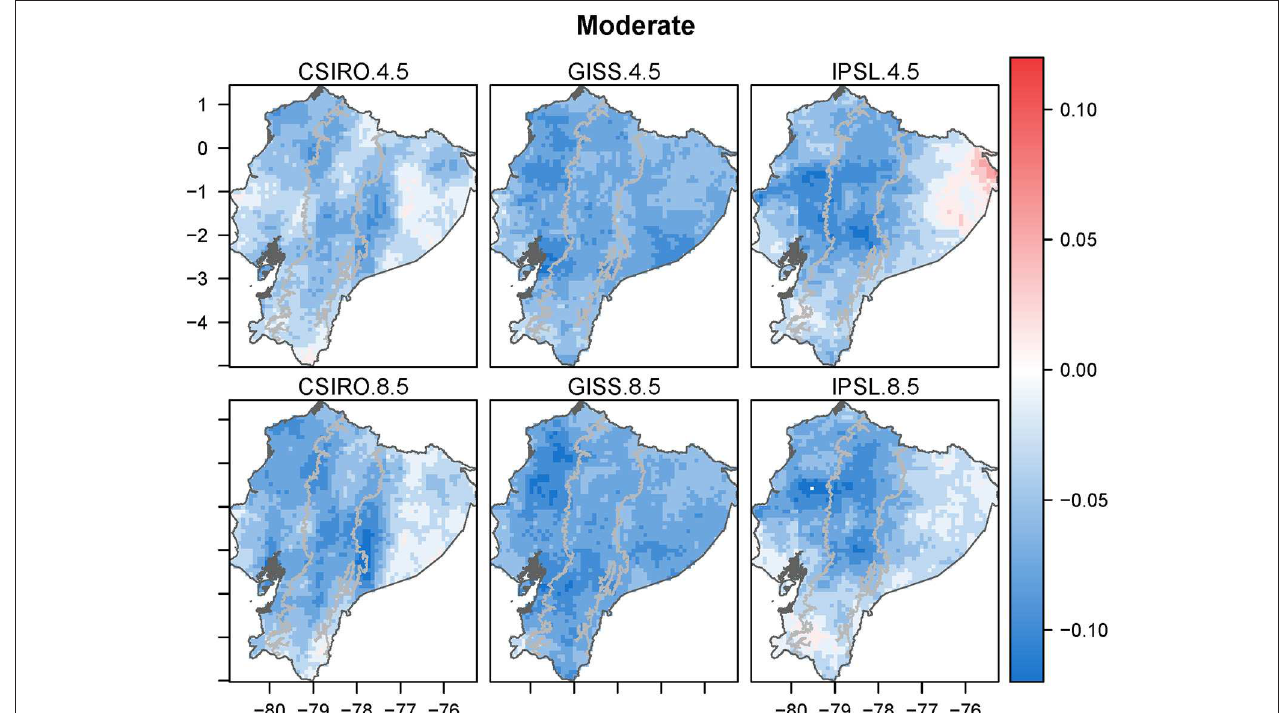
FIGURE 4 | Spatial distribution of change for moderate drought probability. RCP (rows) and GCM (columns). White pixels indicate no change.